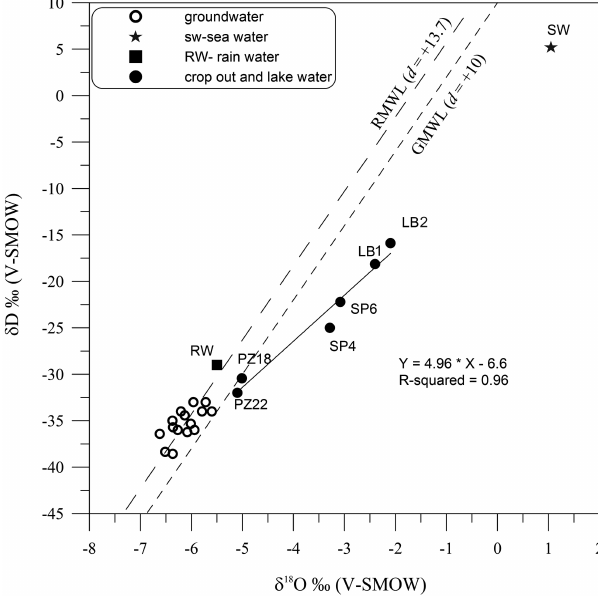
Fig. 5. δ 18 O vs. δ D diagram. The regional meteoric water line (RMWL, Chery, 1988; Celle et al., 2004) and the global meteoric water line (GMWL; Craig, 1961) are drawn for comparison. The equation describing the line produced by evaporation effects is also displayed.